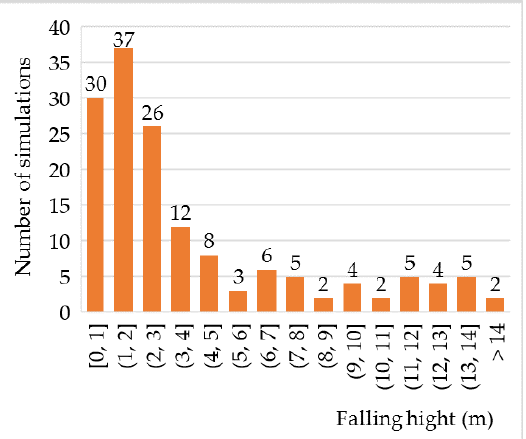
Figure 2. Number of conducted simulations at different drops falling heights. Note: data whose values are given in ranges in analysed papers are not included in the analysis.